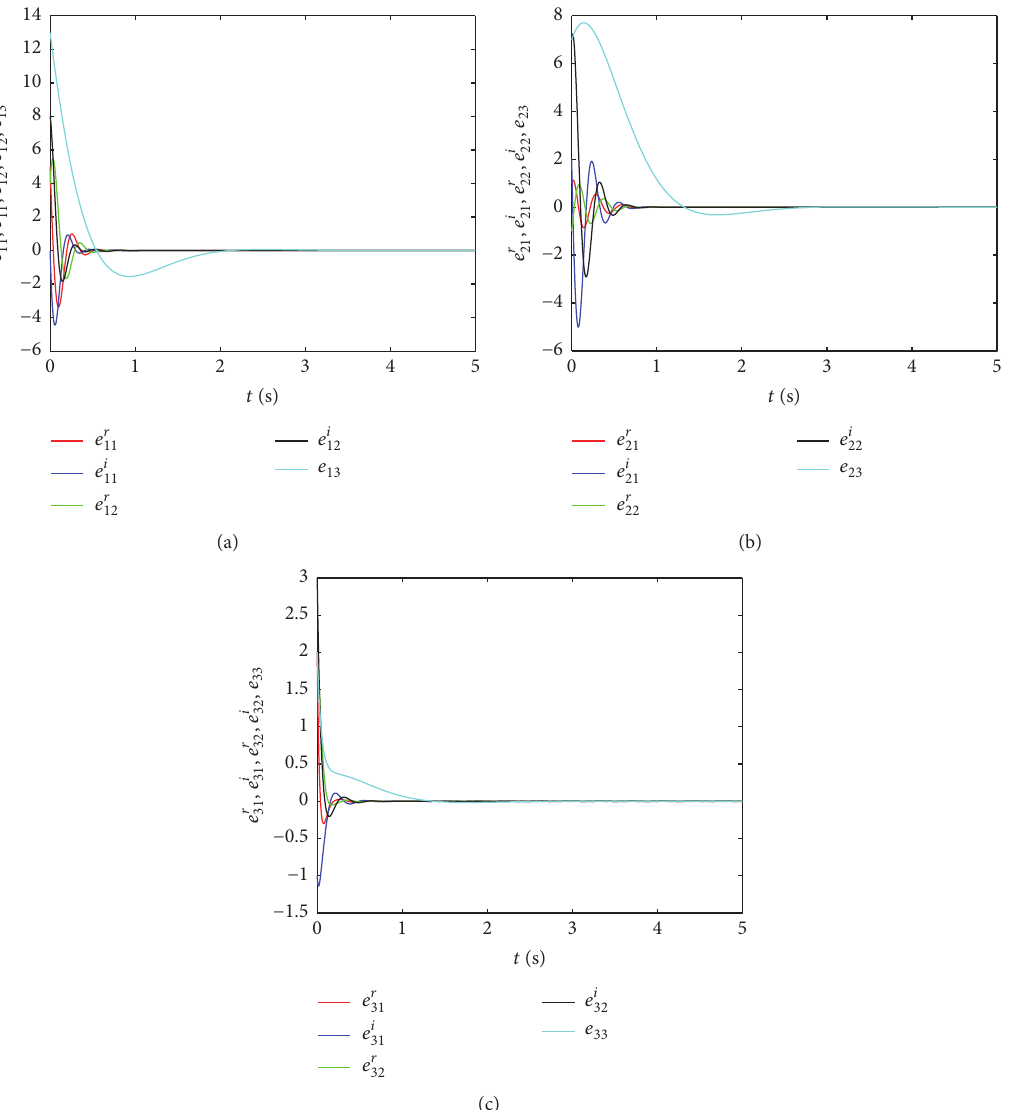
Figure 6: The error dynamics of antisynchronization among 4 -coupled complex PMSM